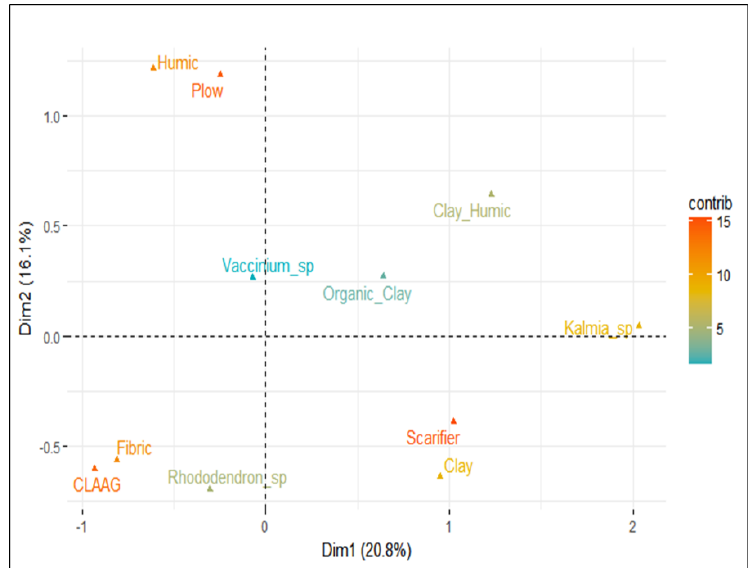
Figure 7. Multiple correspondence analysis summarizing the relationships among Ericaceae cover, silvicultural treatments, and types of microsites exposed. The color gradient represents the contribution of each variable on the two explanatory axes. CLAAG: careful logging around advance growth.